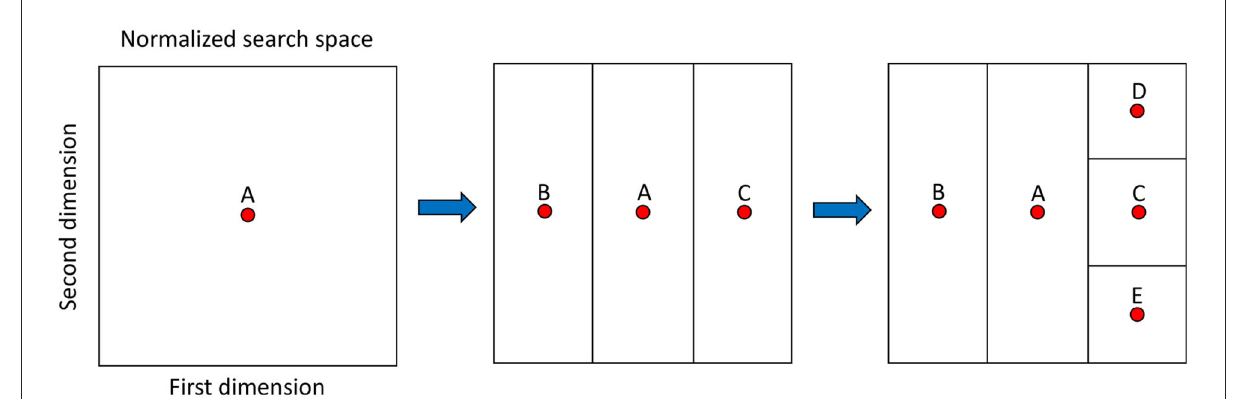
FIGURE4 Main aspects of dividing rectangles (DIRECT) and its search space after two iterations. At the beginning of the initial iteration, point A is the first evaluated and represents the first and only rectangle (square) defined by the search space. It is trisected and results in the rectangles defined by points B and C. At the second iteration, the rectangle defined by point C is selected and trisected resulting in rectangles defined by points D and E.